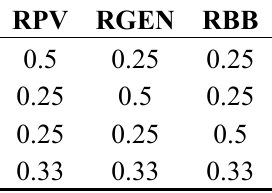
Table 4. Values of the Relative Contributions of Solar PV, Generator and Battery